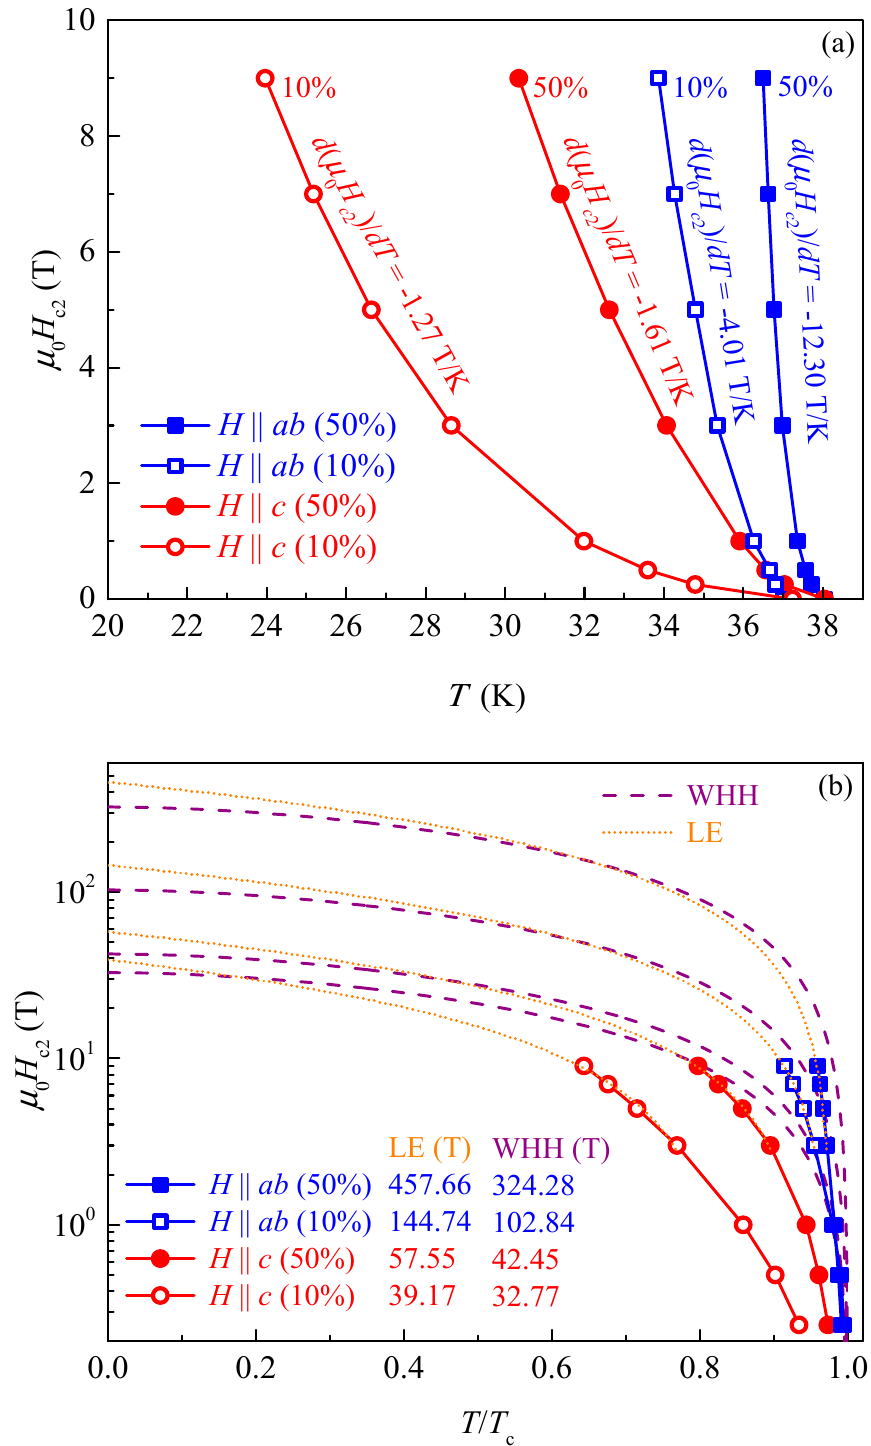
Figure 15. ( a ) μ 0 H c2 - T relations; ( b ) the zero-temperature upper critical fields are extrapolated using Werthamer-Helfand-Hohenberg (WHH) formula and linear extrapolation (LE) method.